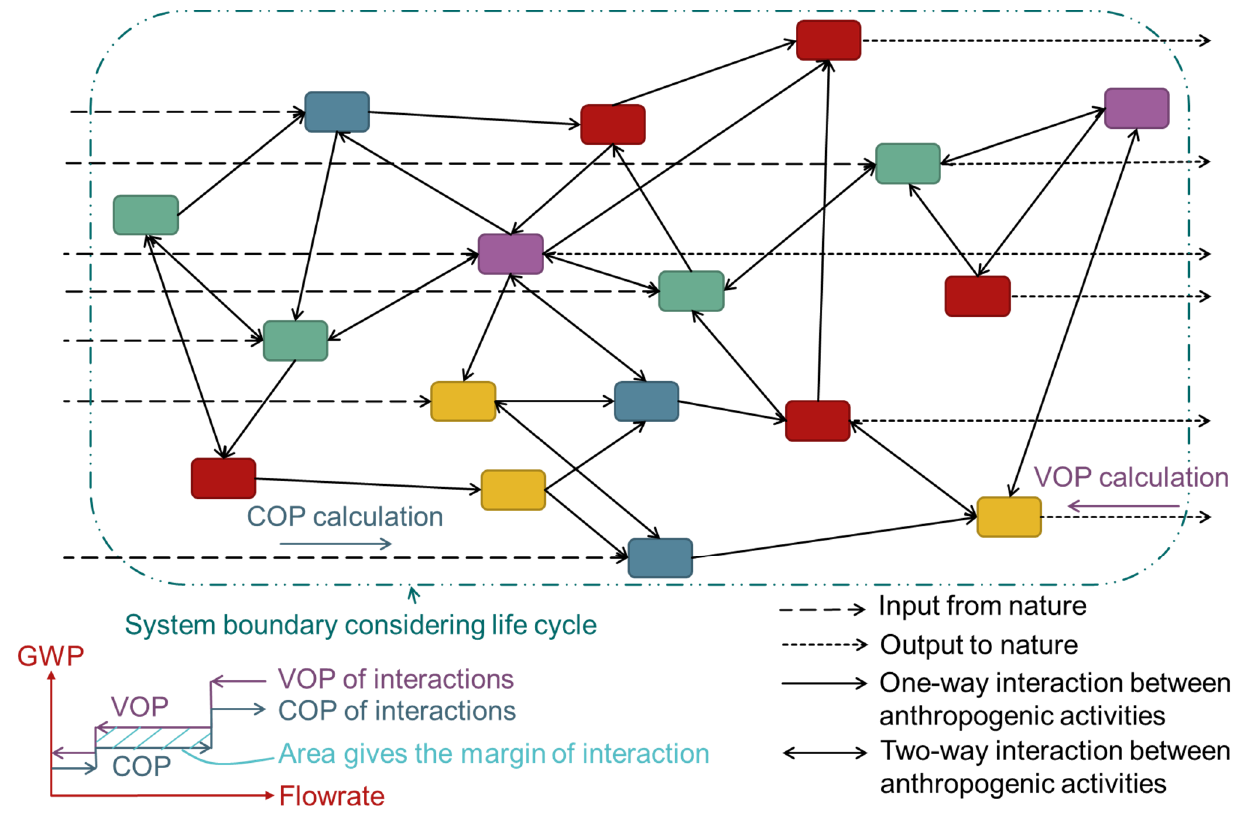
Figure 3. Anthropogenic interactions are represented as nodes (anthropogenic activities) and interconnections (interactions) in a spatially distributed network graph. Each colour of the nodes represents a unique entity.